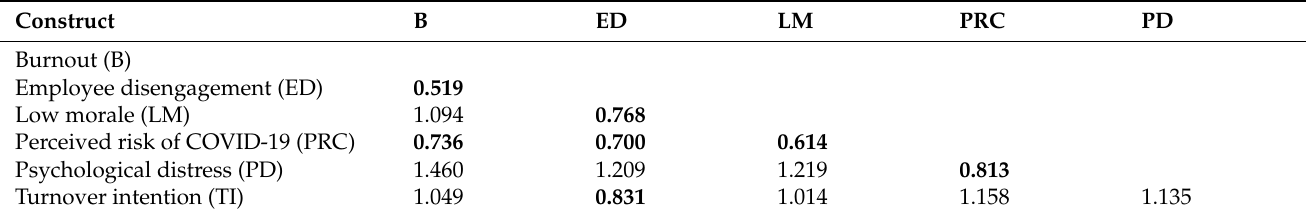
Table 3. Discriminant validity using Heterotrait–Monotrait ratio (HTMT).